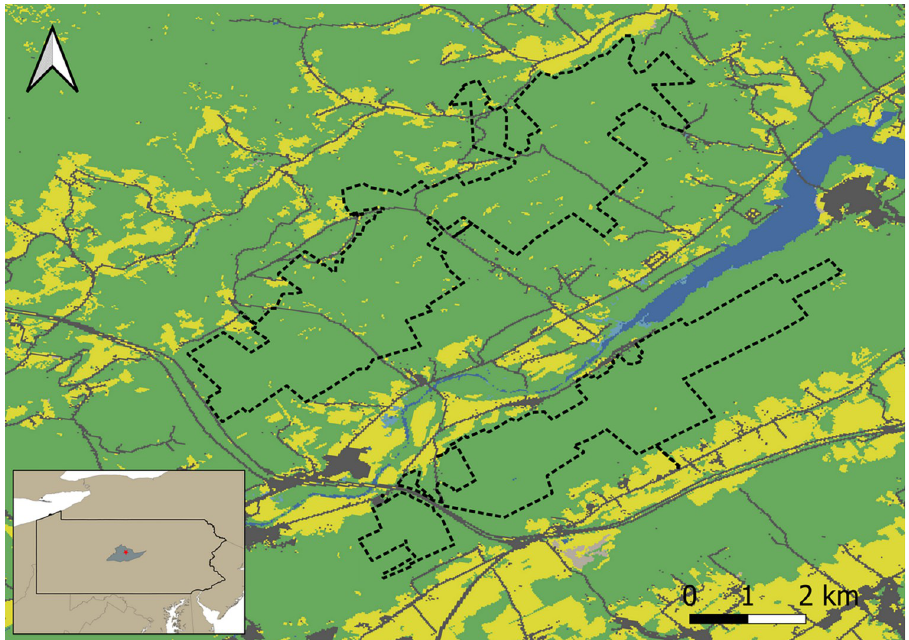
Fig 1. Study area. Map of our study area located in Pennsylvania State Game Lands 92 and 323 (enclosed with dotted boundaries) in Centre County, Pennsylvania. Forest areas are shown in green, pastures and agricultural areas in yellow, water in blue, and developed areas (including roads) in gray. Map inset at bottom left shows the location of Centre County (shaded gray) and the study area (red asterisk) within Pennsylvania.